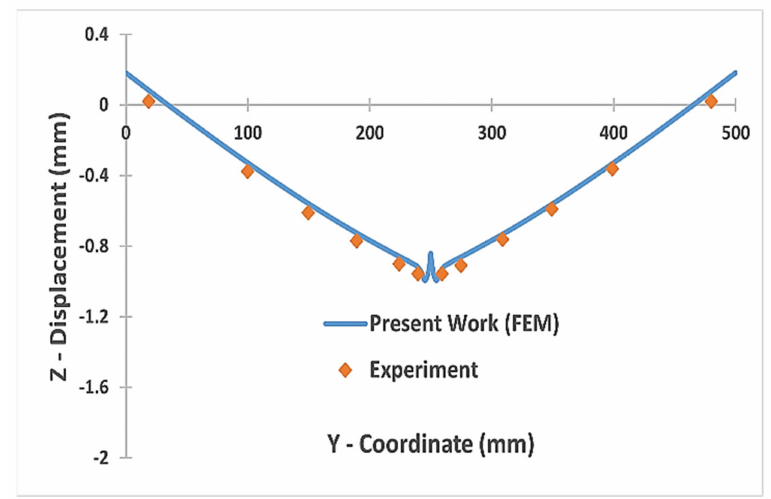
Figure 7. Vertical deflection in Z-direction along line